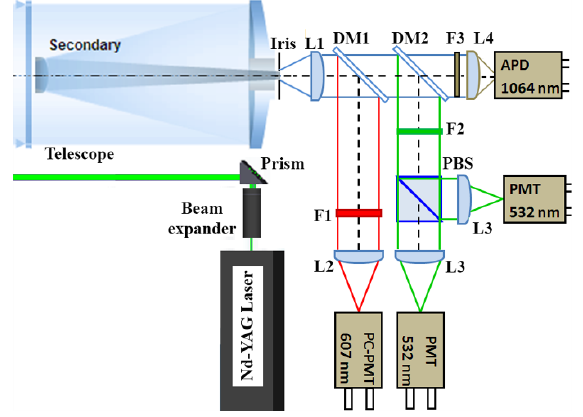
Figure 1 IRIS Polarization/Raman lidar setup The particle backscatter coefficient at 532 nm, the particle extinction coefficient at 532 nm and the respective particle extinction-to-backscatter ratio (lidar ratio) at 532 nm are determined from the elastic and inelastic return signals in the way described by Ansmann et al. [14]. Aerosol Optical Depth (AOD) at 550 nm taken from the Moderate Resolution Imaging Spectroradiometer (MODIS) Deep Blue collection (MOD08, MYD08) available from the